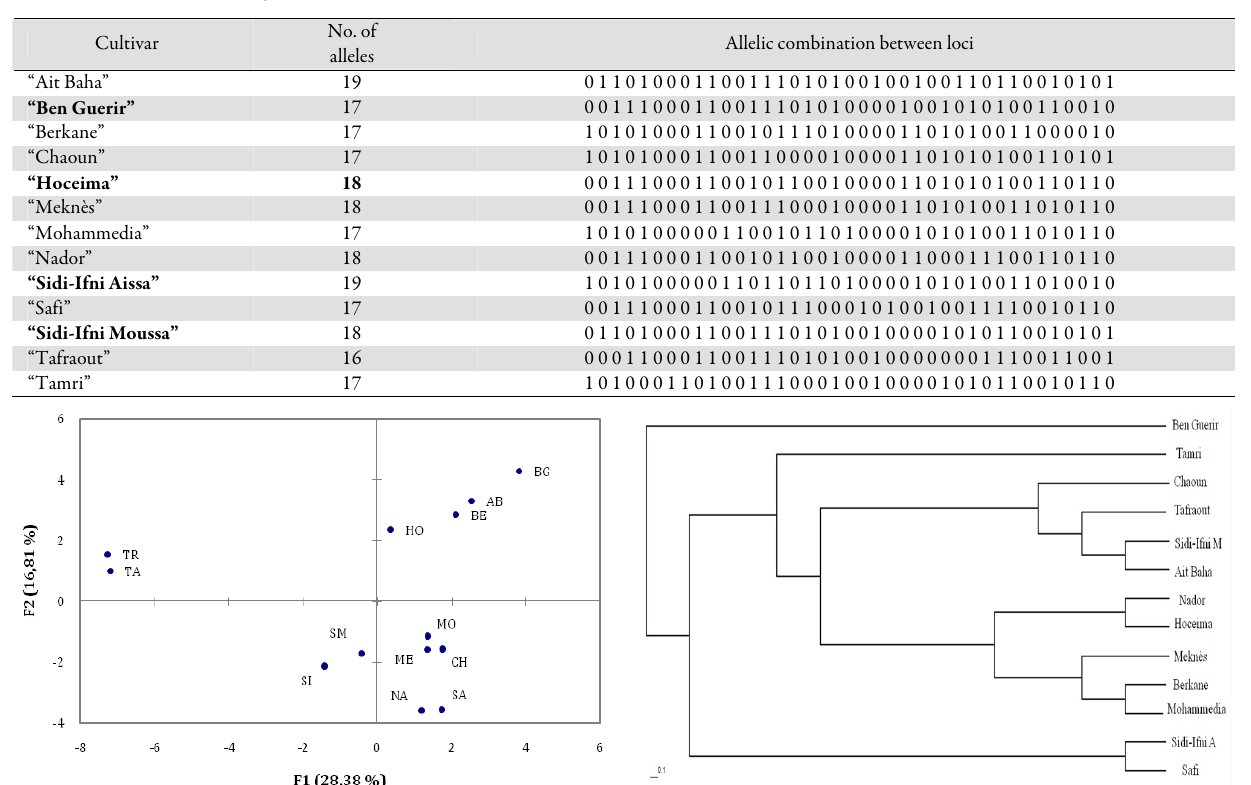
Fig. 2. Opuntia cultivars projected in the factorial plan based on dissimilarity of their allelic